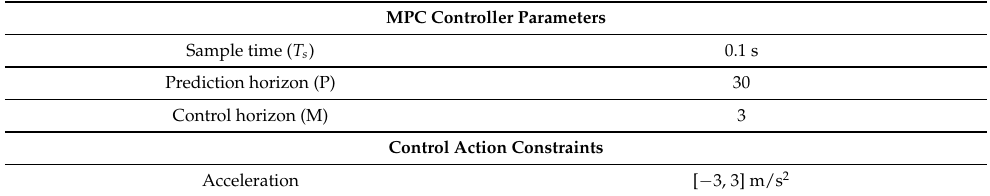
Table 2. MPC design parameters.